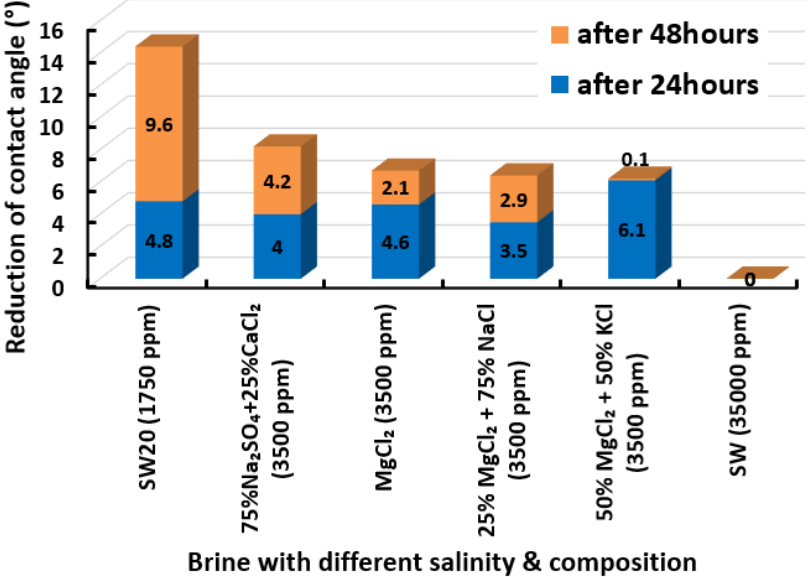
Figure 23. Contact angle reduction results; six selected smart water (SW)